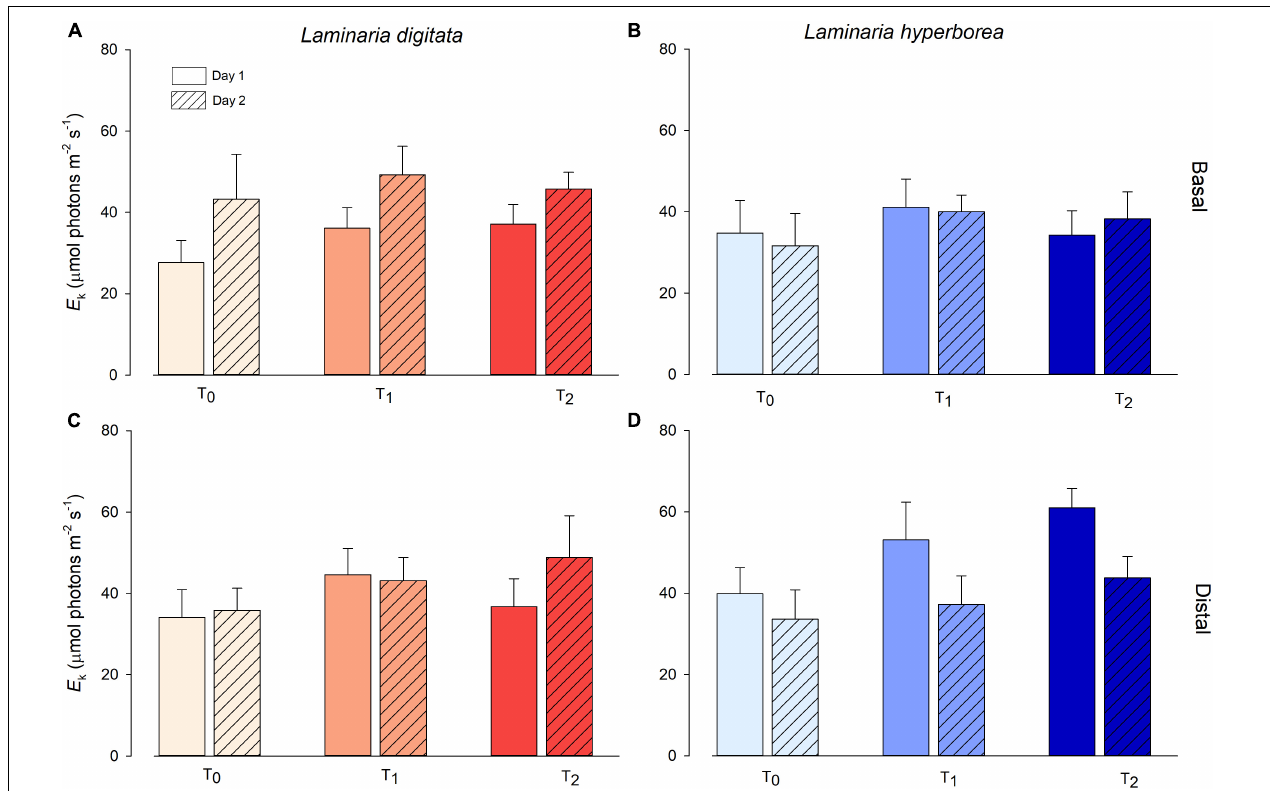
FIGURE 3 | Minimum saturation intensity ( E k , µ mol photons m − 2 s − 1 ) of L. digitata (A,C) and L. hyperborea (B,D) at the distal and basal sections of blade tissue under each temperature treatment on days 1 and 2 of the simulated heat spike event, as measured via PAM fluorometry. Data presented as mean ± SE ( n = 4 individual aquaria per